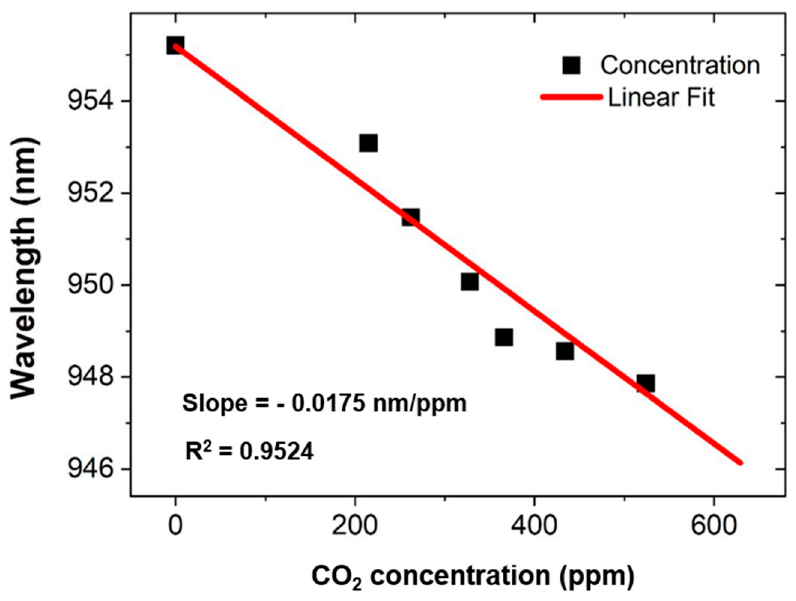
Figure 6. Linear response of the sensor for different concentrations of the CO 2 gas. Table 3. Detailed performance of the sensor using di ff erent concentrations of the CO 2 gas.